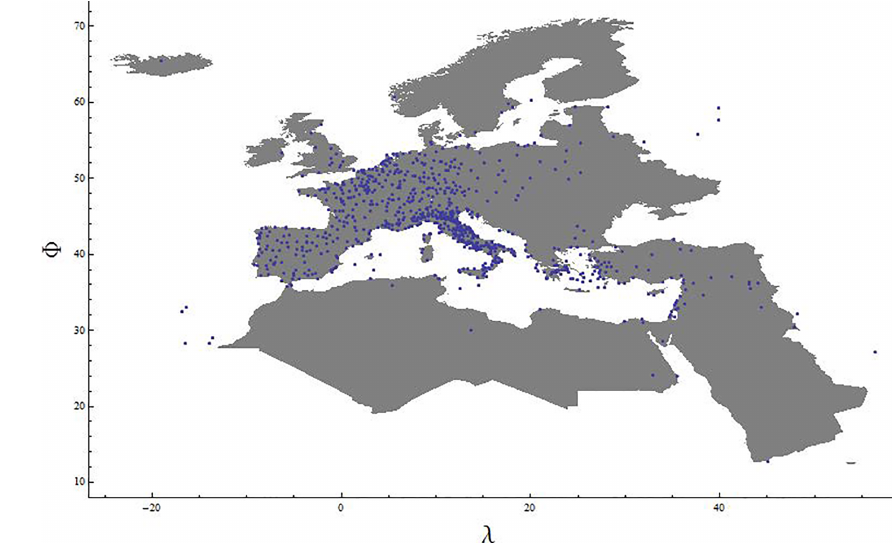
Figure 7. Map of contemporary counterparts (blue dots) of Riccioli’s locations considered in the present analysis.